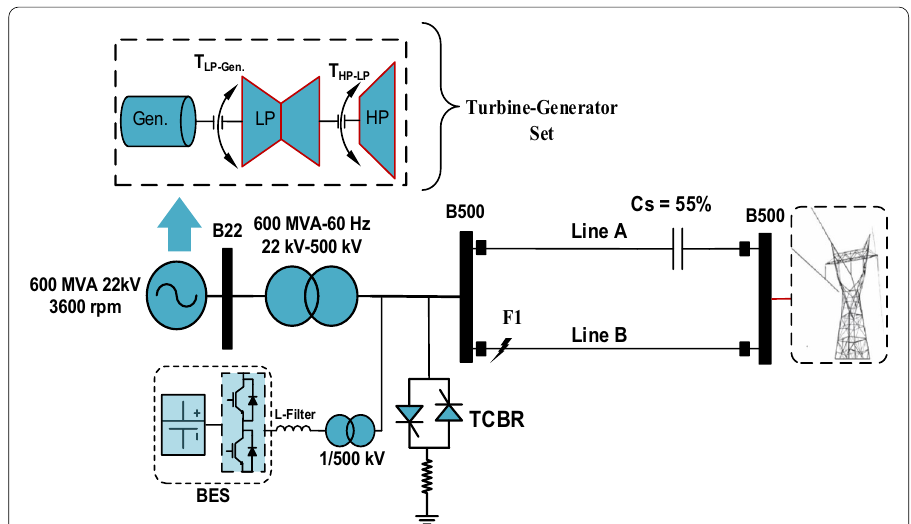
Fig. 1 The IEEE second benchmark with turbogenerator shaft details incorporating BES and resistive brake